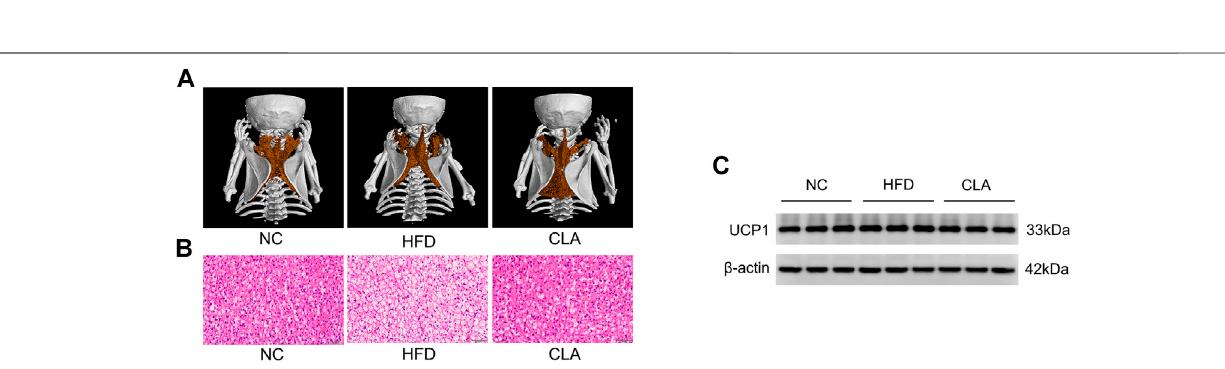
Frontiers in Pharmacology |